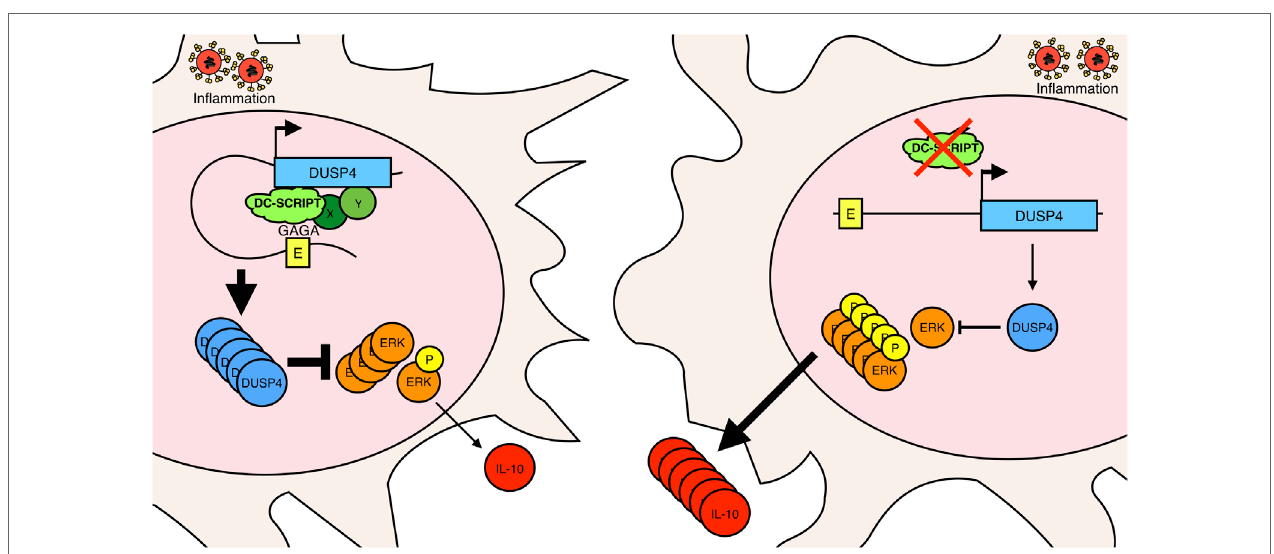
FigUre 6 | Model of DC-SCRIPT mediated control of IL-10 production in DCs. In the presence of DC-SCRIPT (left figure), DC-SCRIPT binds an enhancer (E) for DUSP4 via a GA-rich motif. This leads to enhanced DUSP4 expression, which limits ERK signaling, and subsequent IL-10 production under inflammatory conditions. By contrast, in the absence of DC-SCRIPT (right figure), DUSP4 is only expressed at a low level, thereby enabling higher ERK signaling leading to an increase in IL-10 production. X and Y are potential protein partners in the enhancer complex.